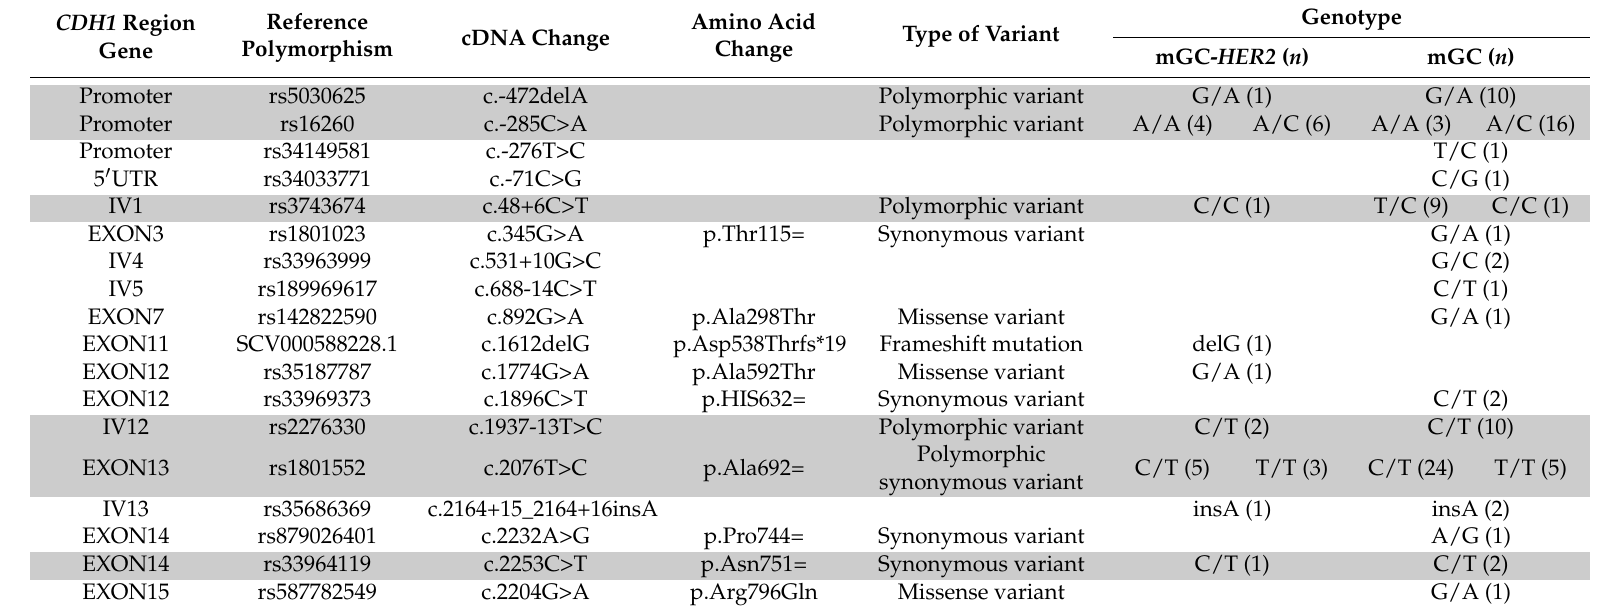
Table 1. CDH1 germline mutations found in mGC according to the HER2